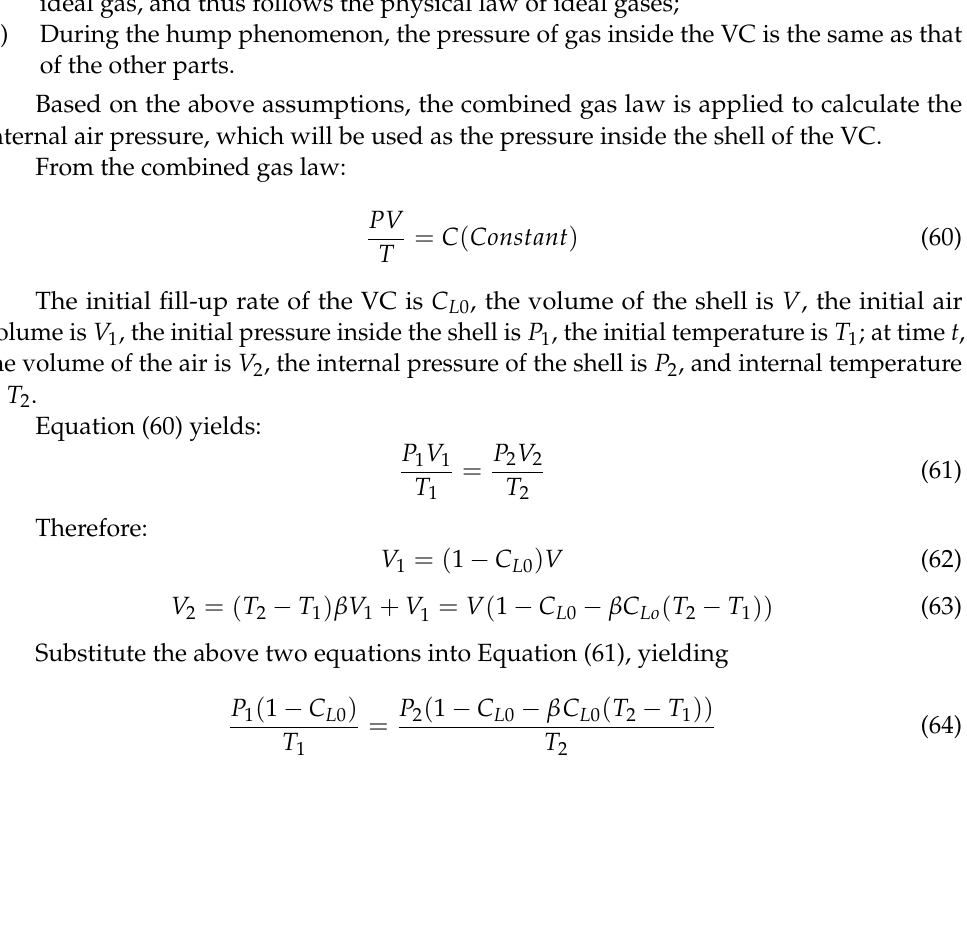
Figure 5. The limited slip torque of the VC.